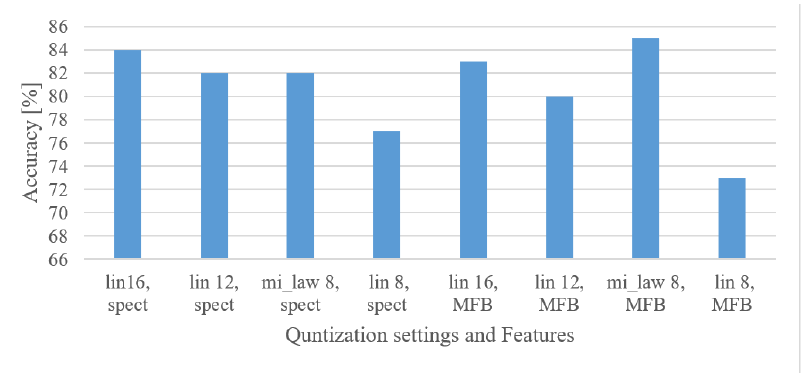
Figure 18. Accuracies for 16, 12, and 8 bit linear, and 8 bit μ -law quantization schemes in the case of spectrograms (spect) and MFBs. spectrograms (spect) and